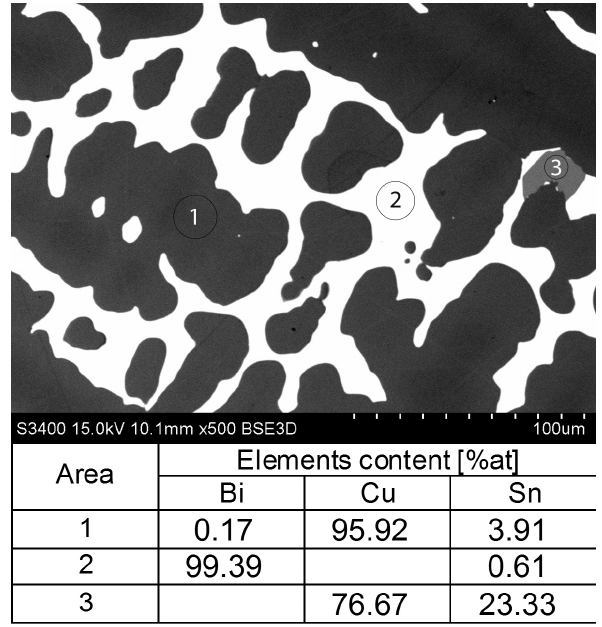
Figure 9: Microstructure of the alloy no 1.